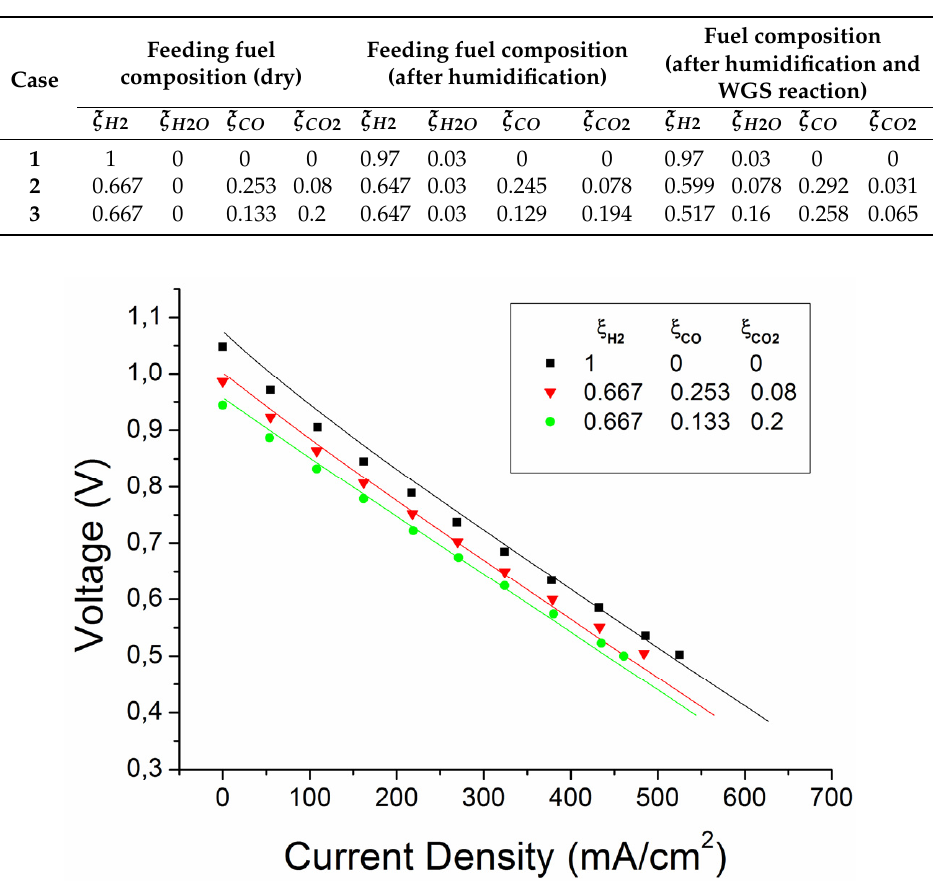
Table 3. Dry H 2 /CO/CO 2 feeding fuel compositions (experimental), fuel compositions after ambient temperature humidification and after WGS reaction at 950 °C (calculated). Related to the results in Figure 5.